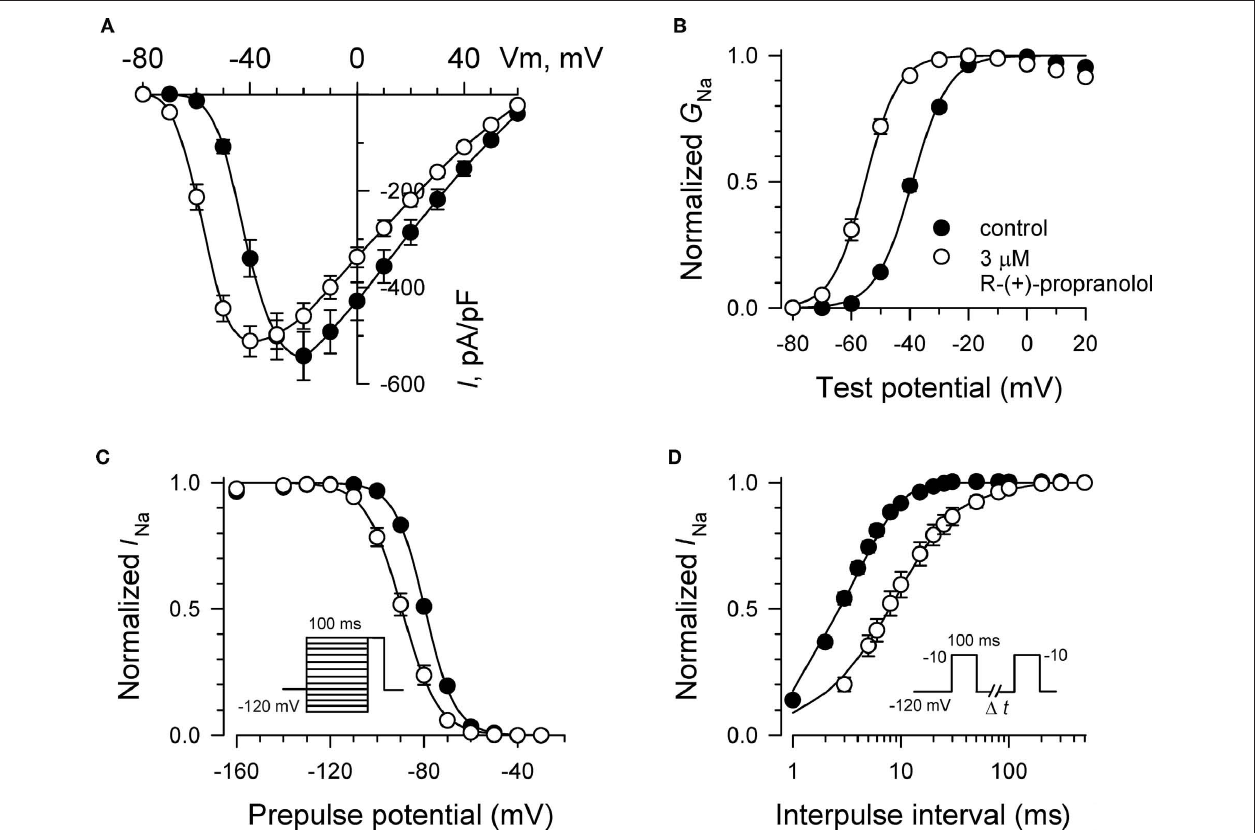
channel availability (“steady-state inactivation”) in the absence and presence 1.5. V of drug measured using a two-pulse protocol illustrated in the inset. (D) Effect of (R)-( + )-propranolol on recovery from inactivation (holding potential − 120 mV). Fit parameters for data in (B–D) are provided in Table 1 , and lines in (B,C) represent Boltzmann fits. Each point represents mean ± SEM from 12 cells.